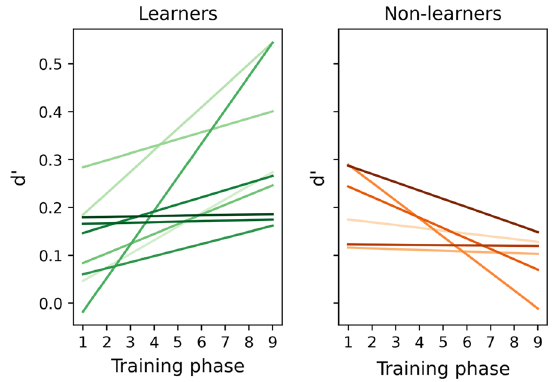
Fig. 4 Individual progression of d’ across the 9 training phases, with the learners in green hues in the left plot and the non‑learners in orange hues in the right plot